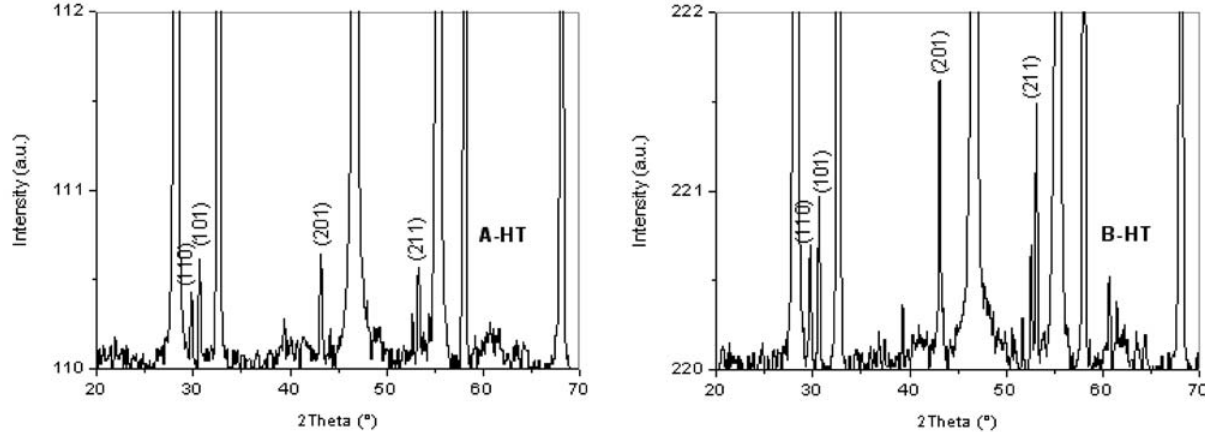
Fig. 2: Enlargements of the XRD patterns for the A-HT and B-HT samples. The indices correspond to β -NaYF